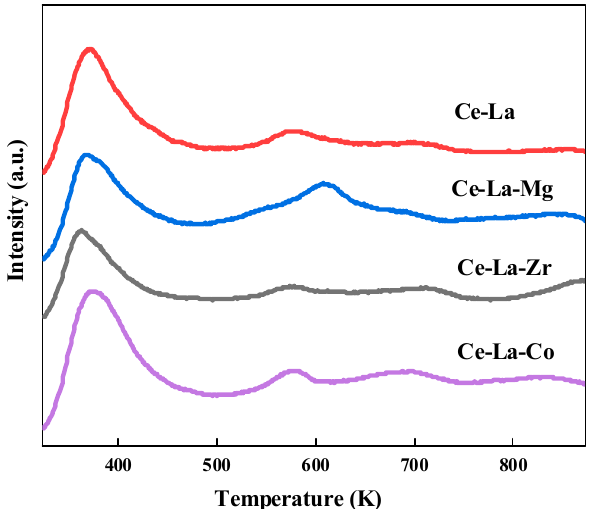
Figure 4. CO 2 -TPD profiles of metal elements doped cerium lanthanum solid solution. Figure 4. CO 2 ⁃ TPD profiles of metal elements doped cerium lanthanum solid solution.